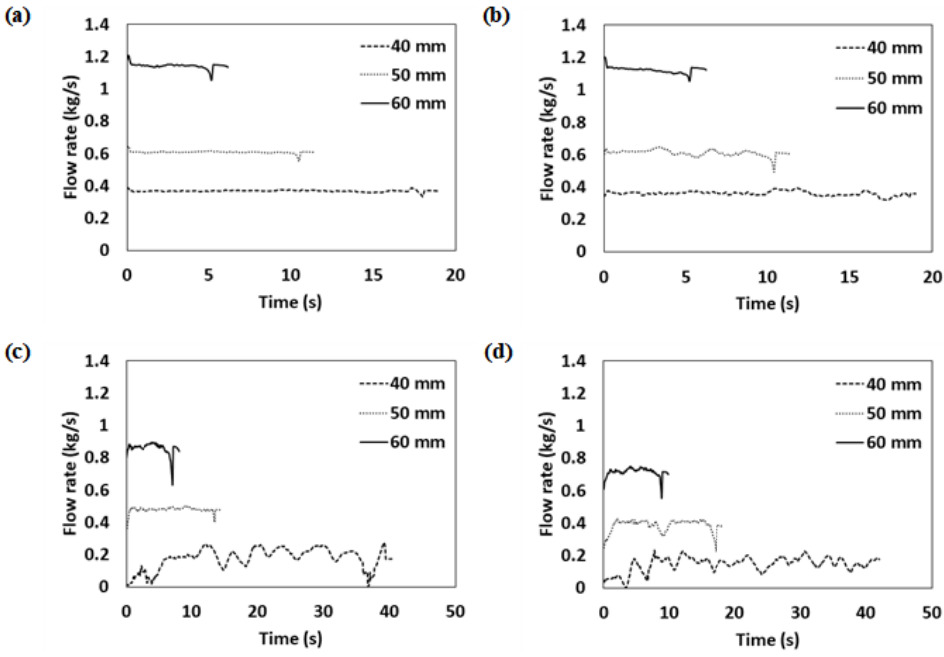
Figure 8. Discharge rate profiles of soybeans with various moisture contents at different orifice sizes of the silo: ( a ) 12%, ( b ) 20%, ( c ) 40%, and ( d ) 60% moisture content.